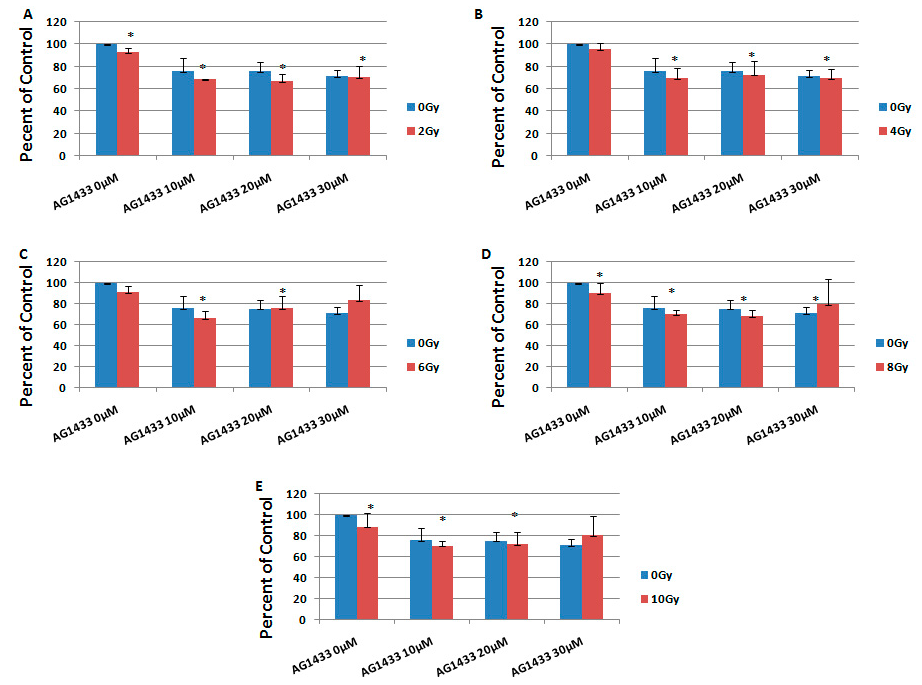
Figure 4. The effect of PDGFR inhibition on ionizing radiation response in 11 HGG cells, 3 days after the treatment. The cells were seeded in 96-well culture plates (5000 cells / well) then irradiated with 2 Gy ( A ); 4 Gy ( B ); 6 Gy ( C ); 8 Gy ( D ); 10 Gy ( E ) and treated with 10, 20, or 30 µ M AG556. The cells were incubated for 3 days and cell viability was determined by MTT assay that is based upon the cleavage of the yellow tetrazolium salt MTT to purple formazan crystals by metabolically active cells. All results show the mean of three independent experiments ± SD (error bars). * p < 0.05 vs. irradiated cells.